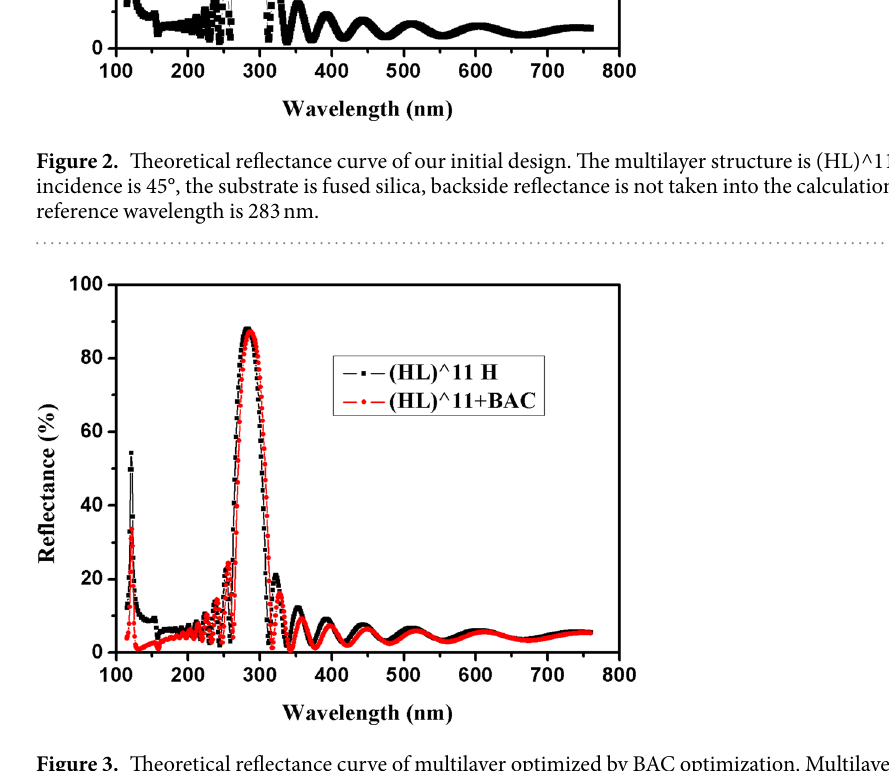
Figure 3. Theoretical reflectance curve of multilayer optimized by BAC optimization. Multilayer structure is (HL)^11 mHmL/2, the value of m is determined by the ratio of 121.6 nm to central wavelength, and the central wavelength is 283